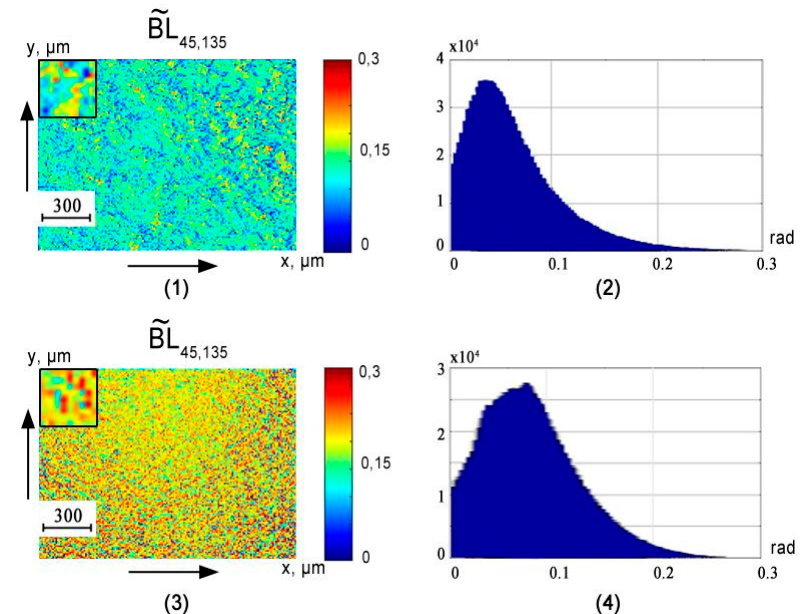
Figure 3. An example of maps and histograms of the red DT spatial distribution fluctuations of the ( ) ~ LB of polycrystalline blood films taken from healthy donor (( 1 ) and ( 2 )) linear birefringence 0;90 and cancer patient (( 3 ) and ( 4 )).